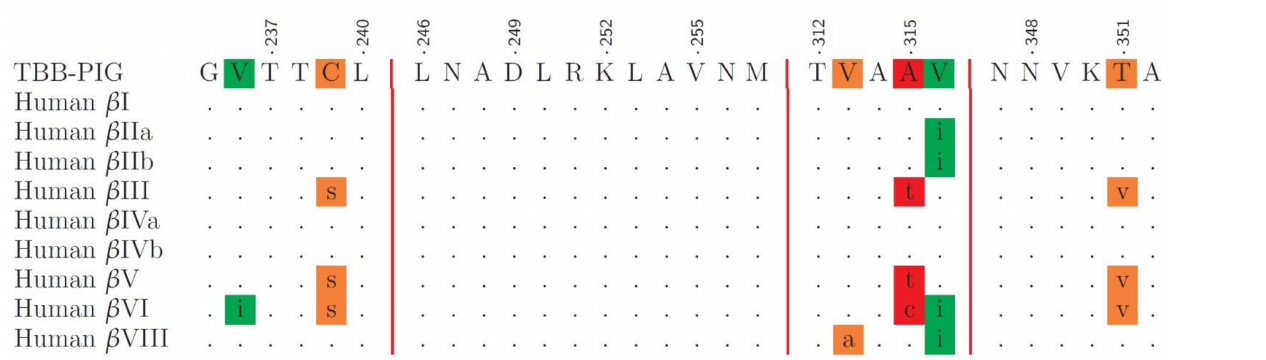
Figure 5. Multiple sequence alignment of porcine β tubulin and human tubulin isotypes over the residues forming the colchicine-binding site. Green-highlighted residues indicate conservative replacements, orange are semiconservative, and red-highlighted residues are not